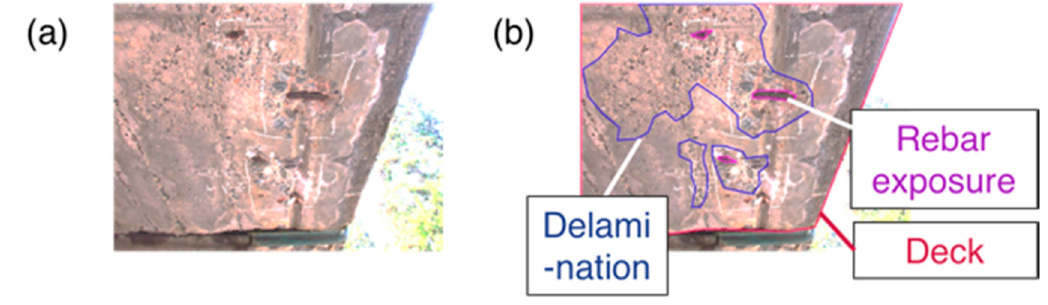
Figure 2. One of the trained images before annotation ( a ); after annotation of “deck,” “delamination” and “rebar exposure” ( b